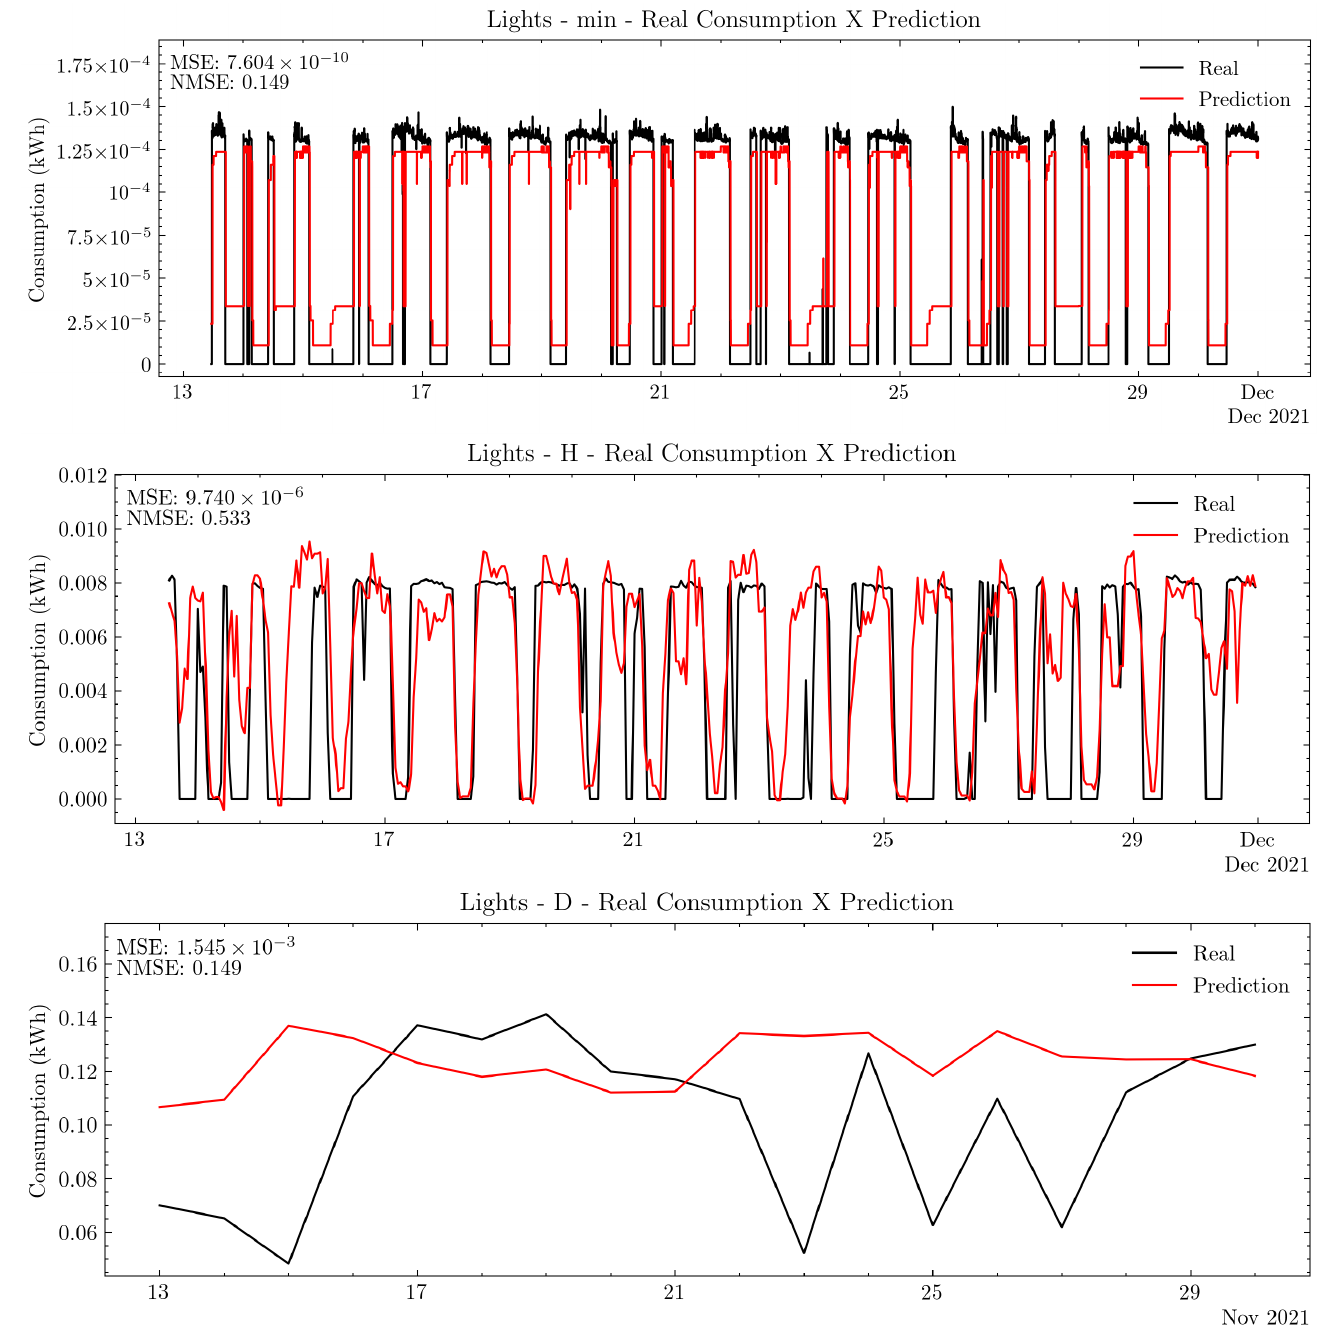
Figure 13. Lights forecast for minute, hourly, and daily frequency